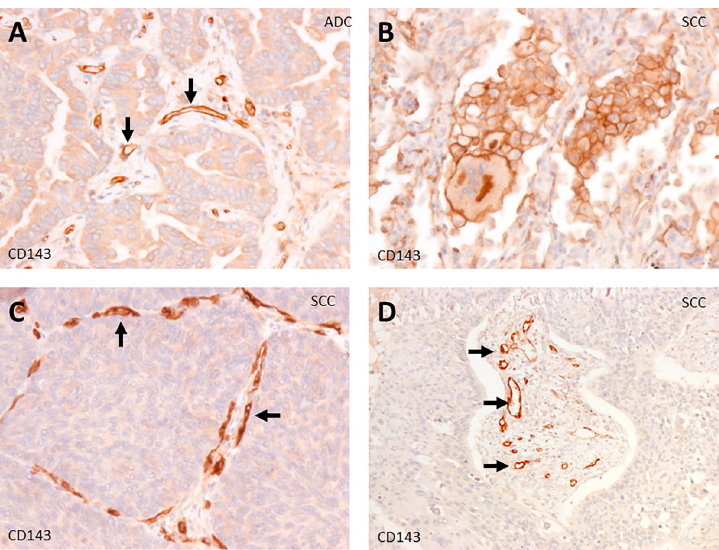
macrophages and gigantic cell (B). Magnification: 100X (D), 200X (A, B, C).